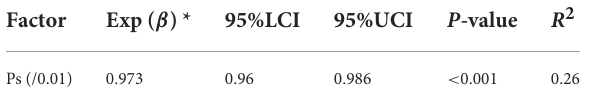
Ps (/0.01) 0.973 0.96 0.986 < 0.001 0.26